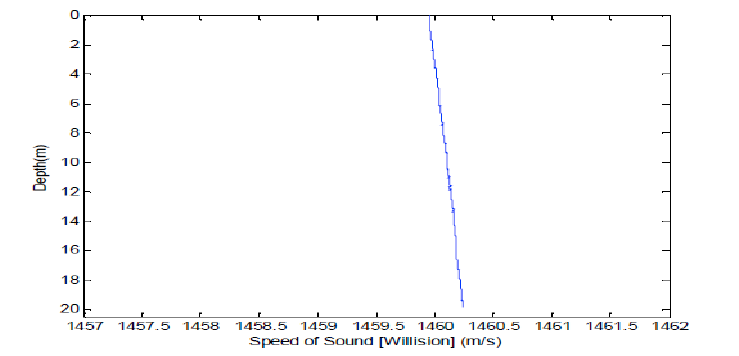
Figure 6. Sound speed profile.